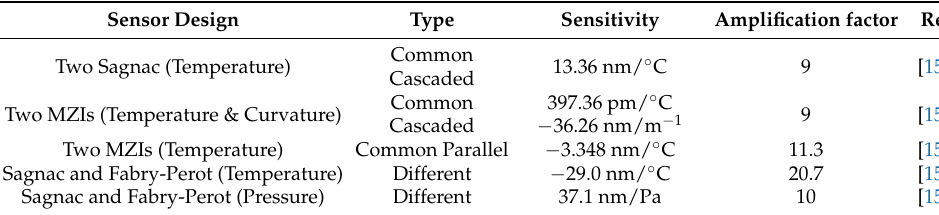
Table 11. Separate type of multiple in-fiber interferometric